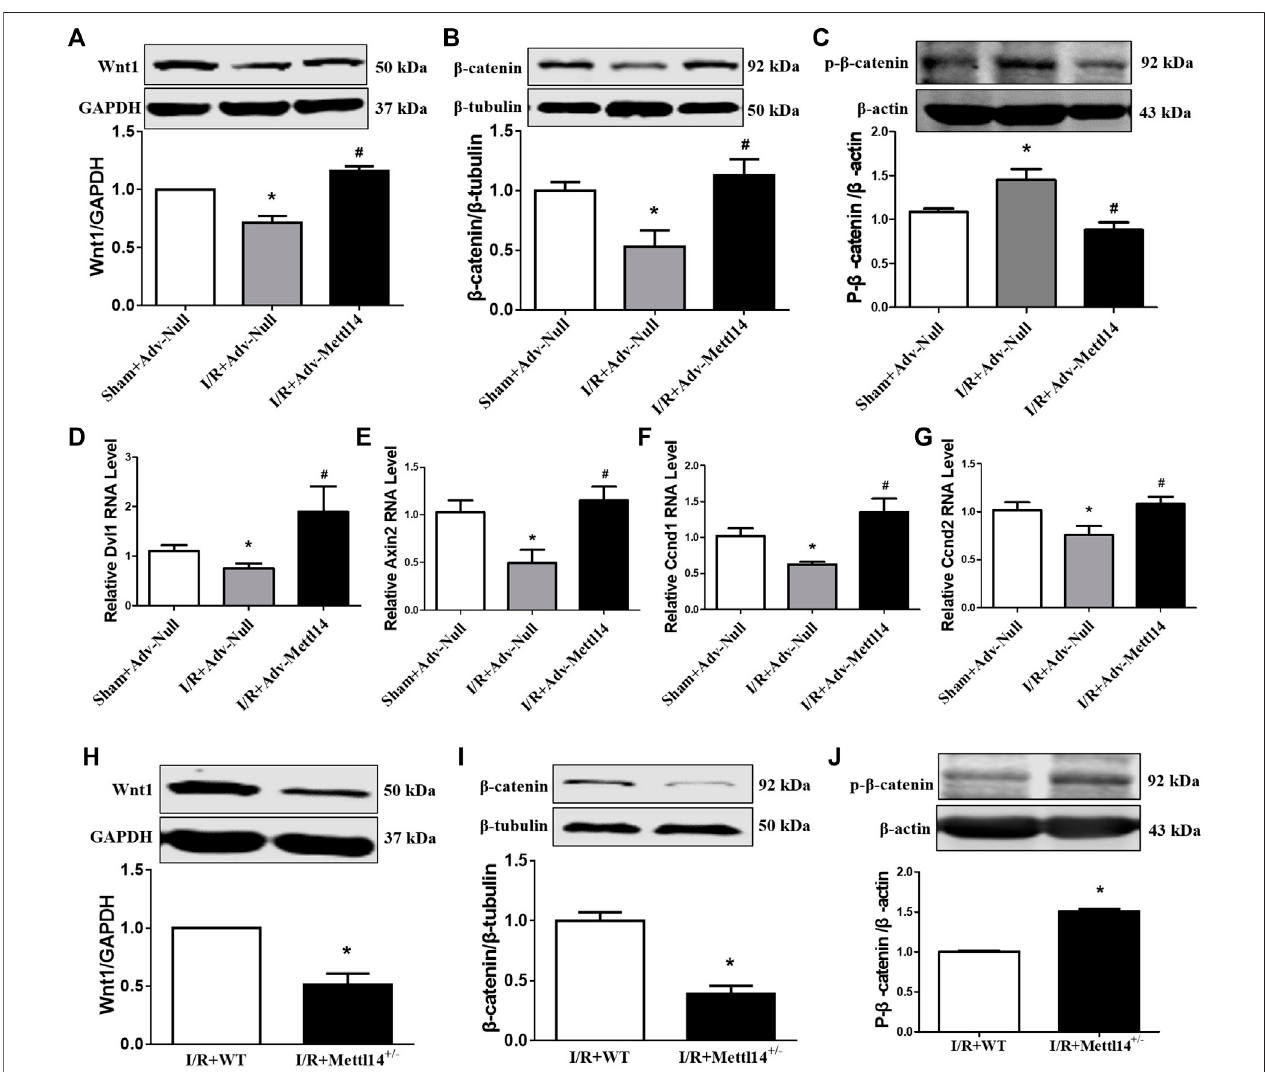
FIGURE6| Mettl14regulatesI/R injurybyactivatingtheWnt/ β -cateninpathway. (A – C) Mouseheartswereinfectedbyadenovirus.Theinfectedmice weretreated toI/Rorshamoperation. (A) TheWnt1expressionwasanalyzedbyWesternblotting.Sham+Adv-Null n (cid:2) 4,I/R+Adv-Null n (cid:2) 4,I/R+Adv-Mettl14 n (cid:2) 3.* p < 0.05versus sham+Adv-Null. # p < 0.05versusI/R+Adv-Null. (B) The β -catenin expression wasanalyzed byWestern blotting. n (cid:2) 5miceper group.* p < 0.05versussham+Adv-Null. # p < 0.05versusI/R+Adv-Null. (C) Thep- β -cateninexpressionwasanalyzedbyWesternblotting. n (cid:2) 4micepergroup.* p < 0.05versussham+Adv-Null. # p < 0.05 versus I/R+Adv-Null. (D) The Dvl1 mRNA level was analyzed by qRT-PCR. Sham+Adv-Null n (cid:2) 4, I/R+Adv-Null n (cid:2) 3, I/R+Adv-Mettl14 n (cid:2) 3. * p < 0.05 versus sham+Adv-Null. # p < 0.05versusI/R+Adv-Null. (E) TheAxin2mRNAlevelwasanalyzed byqRT-PCR.Sham+Adv-Null n (cid:2) 5,I/R+Adv-Null n (cid:2) 5,I/R+Adv-Mettl14 n (cid:2) 3. * p < 0.05 versus Sham+Adv-Null. # p < 0.05 versus I/R+Adv-Null. (F) The Ccnd1 mRNA level was analyzed by qRT-PCR. Sham+Adv-Null n (cid:2) 5, I/R+Adv-Null n (cid:2) 4, I/ R+Adv-Mettl14 n (cid:2) 3. * p < 0.05 versussham+Adv-Null. # p < 0.05 versus I/R+Adv-Null. (G) The Ccnd2 mRNAlevel wasanalyzed by qRT-PCR. Sham+Adv-Null n (cid:2) 5,I/ R+Adv-Null n (cid:2) 4,I/R+Adv-Mettl14 n (cid:2) 3.* p < 0.05versussham+Adv-Null. # p < 0.05versusI/R+Adv-Null. (H – J) TheMettl14knockdownmice weresubjectedtosham or I/R operation. (H) The Wnt1 expression was analyzed by Western blotting. * p < 0.05 versus IR+WT. n (cid:2) 5 mice per group. * p < 0.05 versus I/R+WT. (I) The β -catenin expression was analyzed by Western blotting. n (cid:2) 5 mice per group. * p < 0.05 versus IR+WT. (J) The p- β -catenin expression was analyzed by Western blotting. n (cid:2) 3 mice per group. * p < 0.05 versus IR+WT. Data are represented as mean ± SEM.